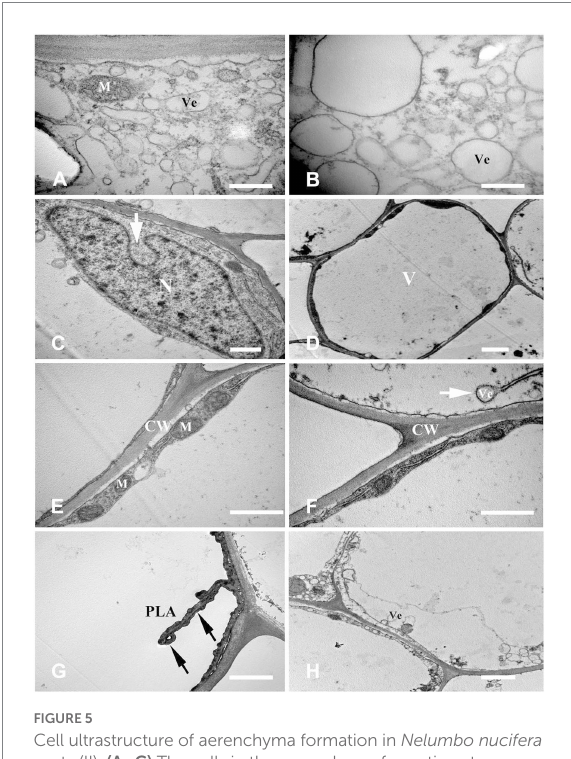
FIGURE 6 Cell ultrastructure of aerenchyma formation in Nelumbo nucifera roots (III). (A–F) The cells in the aerenchyma expansion stage. (A) Distribution of vesicles and distortion of organelles; (B) Fusion of vesicular membrane and plasma membrane; (C) Exocytosis; (D) The vesicles were transported outside the plasma membrane by exocytosis; (E) Complete degradation of cytoplasm and degradation of organelles; and (F) Undegraded organelles. M, mitochondria; Ve, vesicle; CW, cell wall. Bars: A,E,F = 1 μ m, D = 2 μ m, B = 0.5 μ m, and C = 5 μ